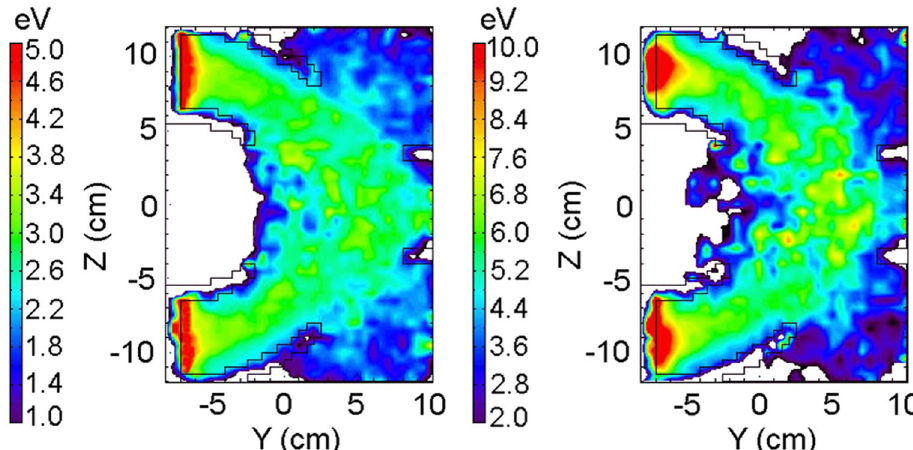
FIG. 7. (Color) T isocontours during steady-state FCAPS injection, presented as f y; z g slices at x (cid:6) 0 . T e from inside the filter coils to the guide solenoid in the cases of initial T